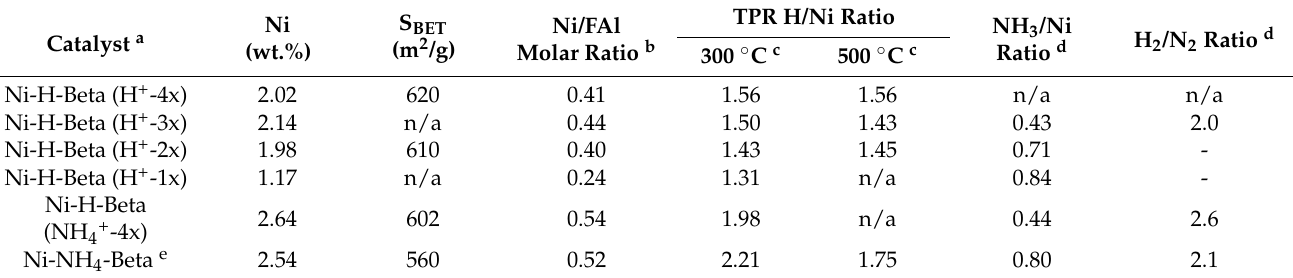
Table 1. Properties of Ni-H-Beta